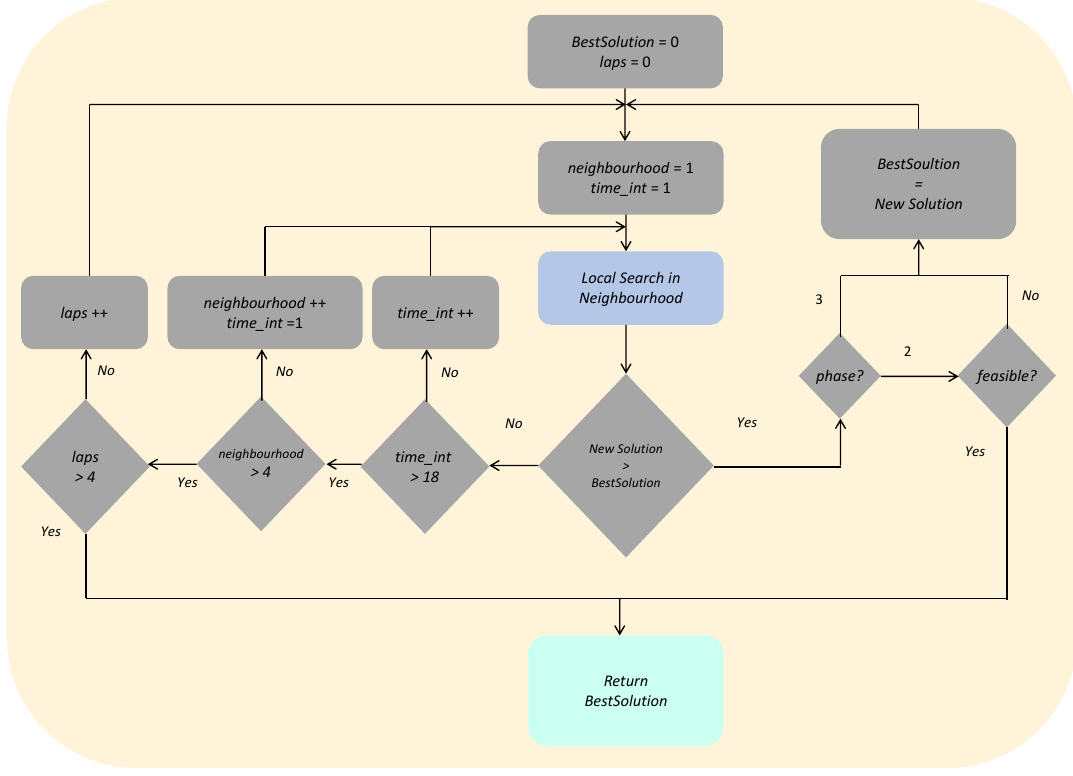
Figure 8. Adapted VNS algorithm for Phases 2 and